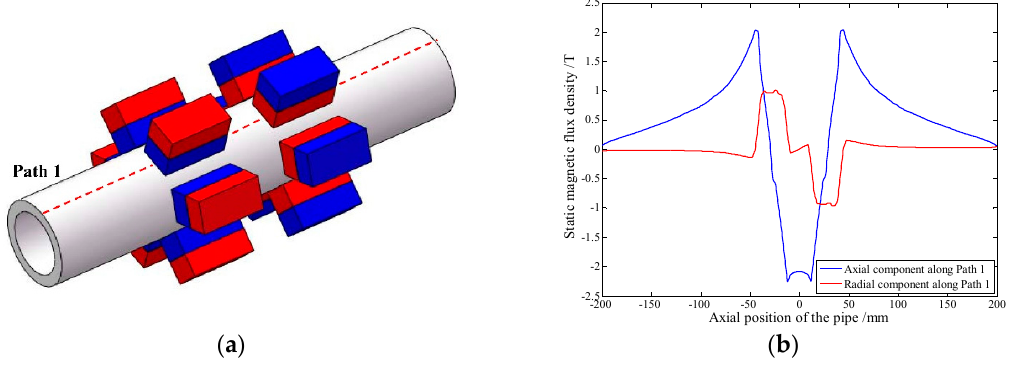
Figure 8. The EMAT configuration with two permanent magnet chains ( a ) the simulation model ( b ) the distribution of static magnetic field along Path 1.